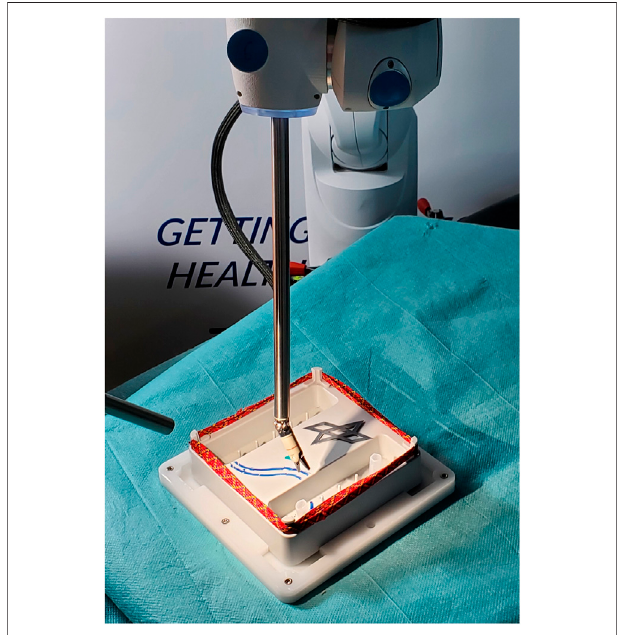
FIGURE 1 | The Nylon Twist training pad from Lübecker Toolbox (LLC, 2021) is performed with the DLR MiroSurge system to train the hand-eye- coordination, bi-manual work, and working over